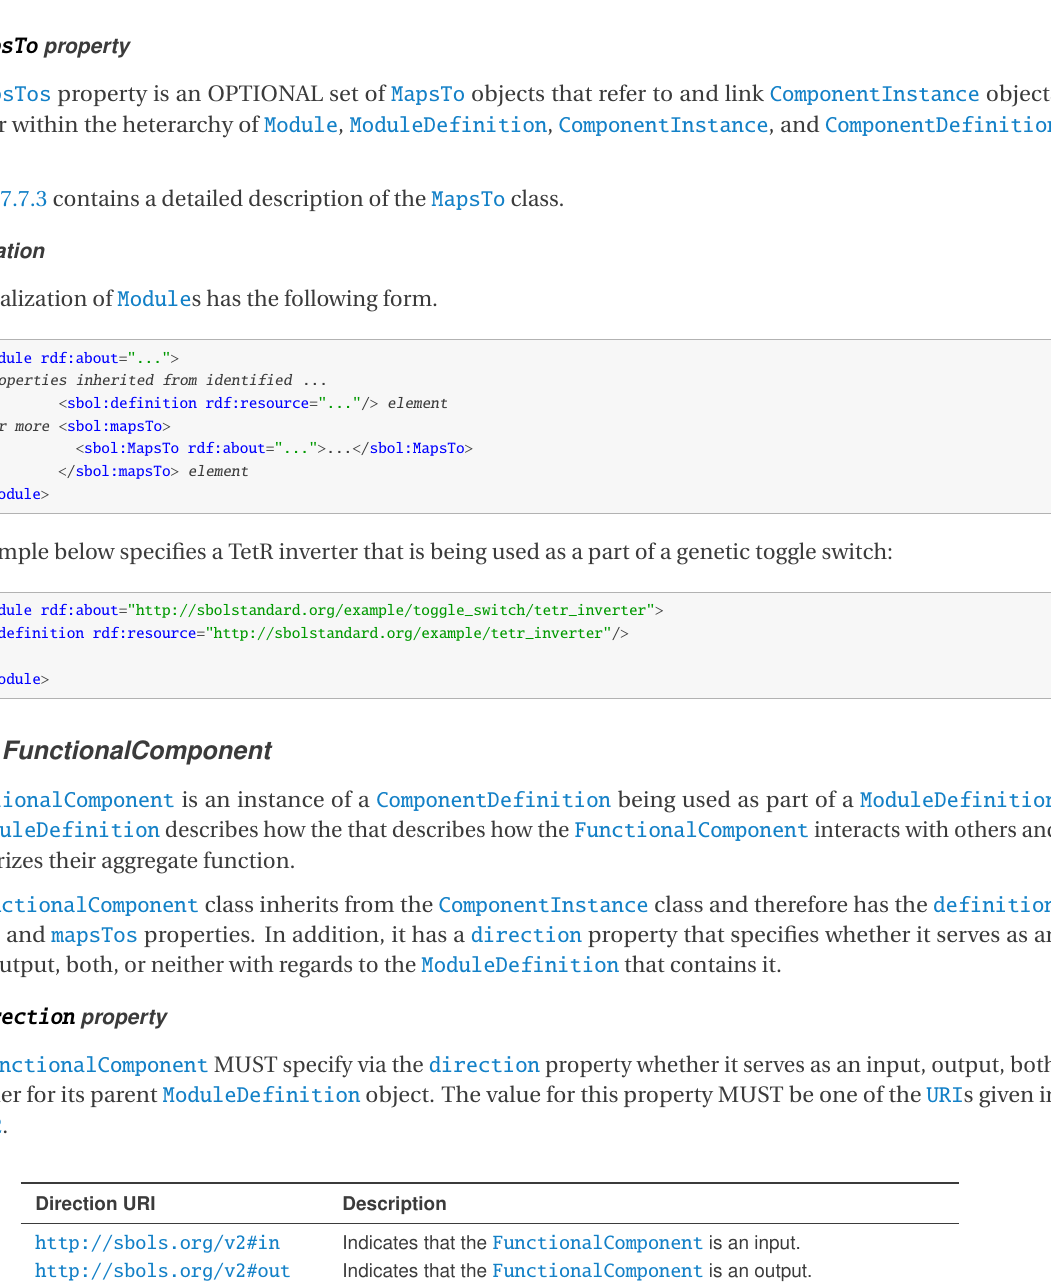
Indicates that the FunctionalComponent is an input. Indicates that the FunctionalComponent is an output. Indicates that the FunctionalComponent is neither an input or output. Table 12: REQUIRED URI s for the direction